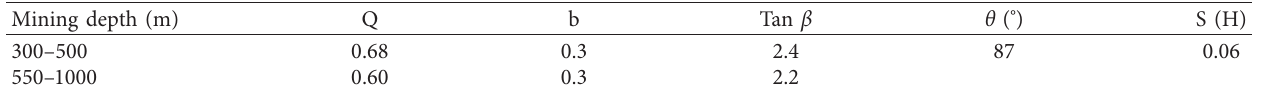
Table 3: Predicted parameters of PIM in the case of repeated